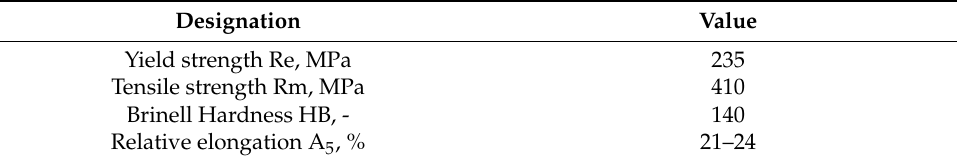
Table 1. Basic mechanical properties of the S235 steel